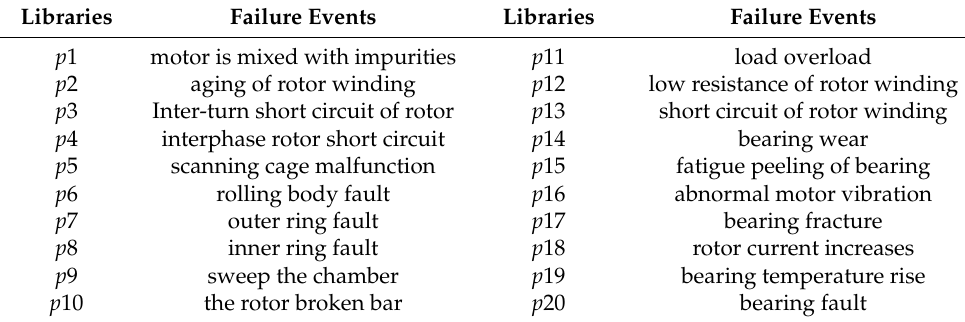
Table 2. The table of bearing fault event.